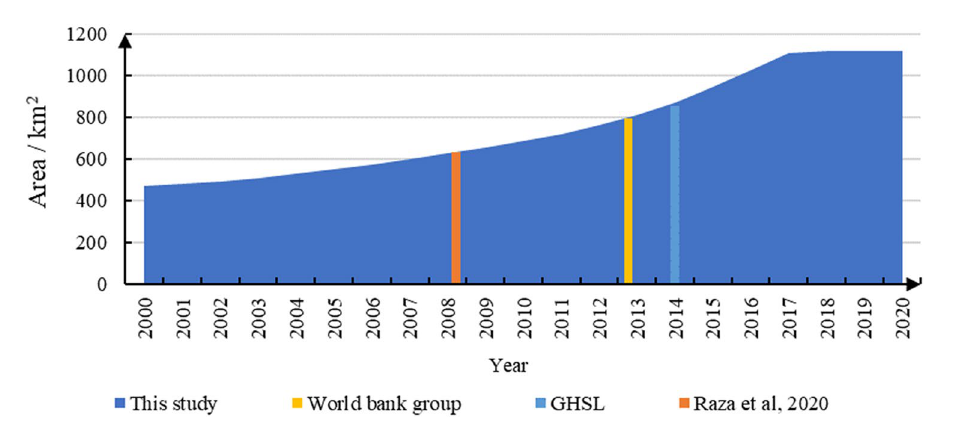
Figure 7. Urban area of Karachi estimated using this study and four open-access